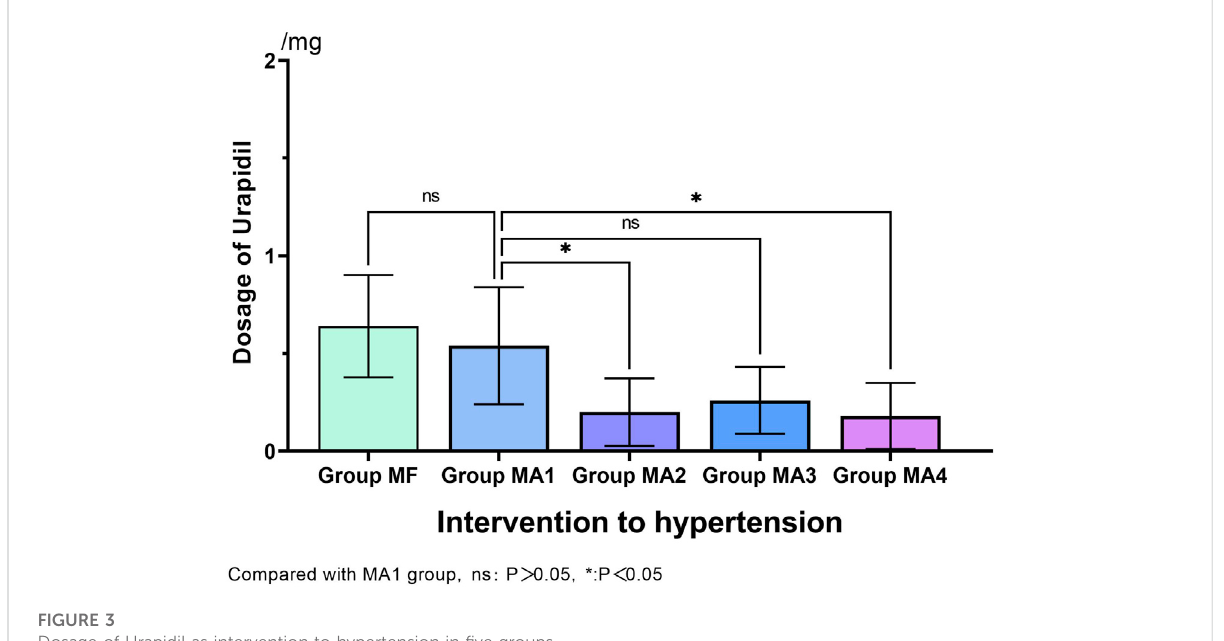
FIGURE 3 Dosage of Urapidil as intervention to hypertension in fi ve groups.